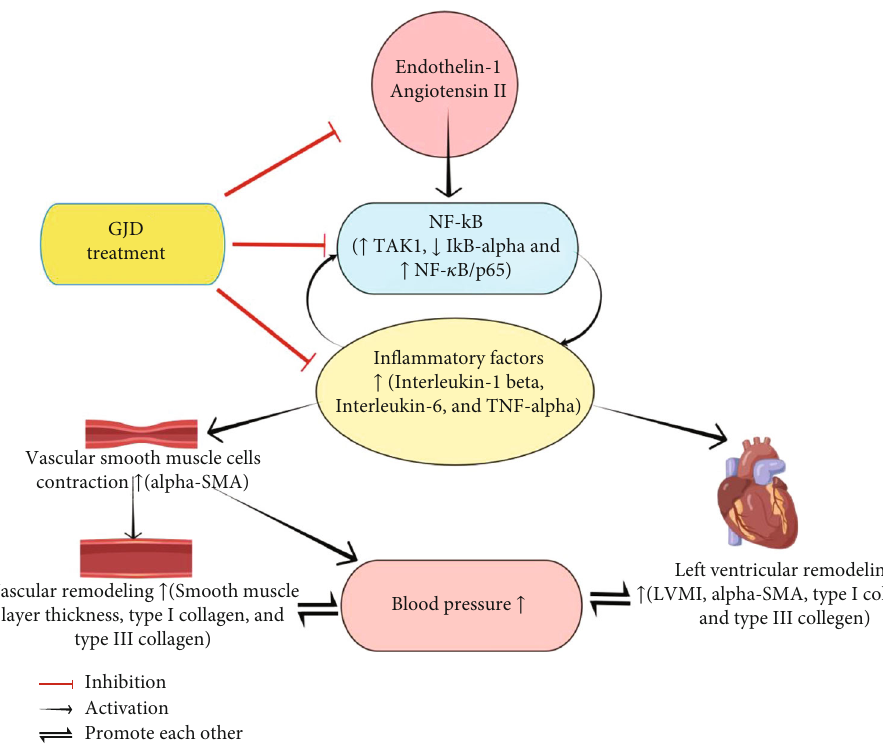
Figure 10: Flowchart of possible mechanisms of GJD attenuates hypertension and cardiovascular remodeling through inhibition NF- κ B, created by